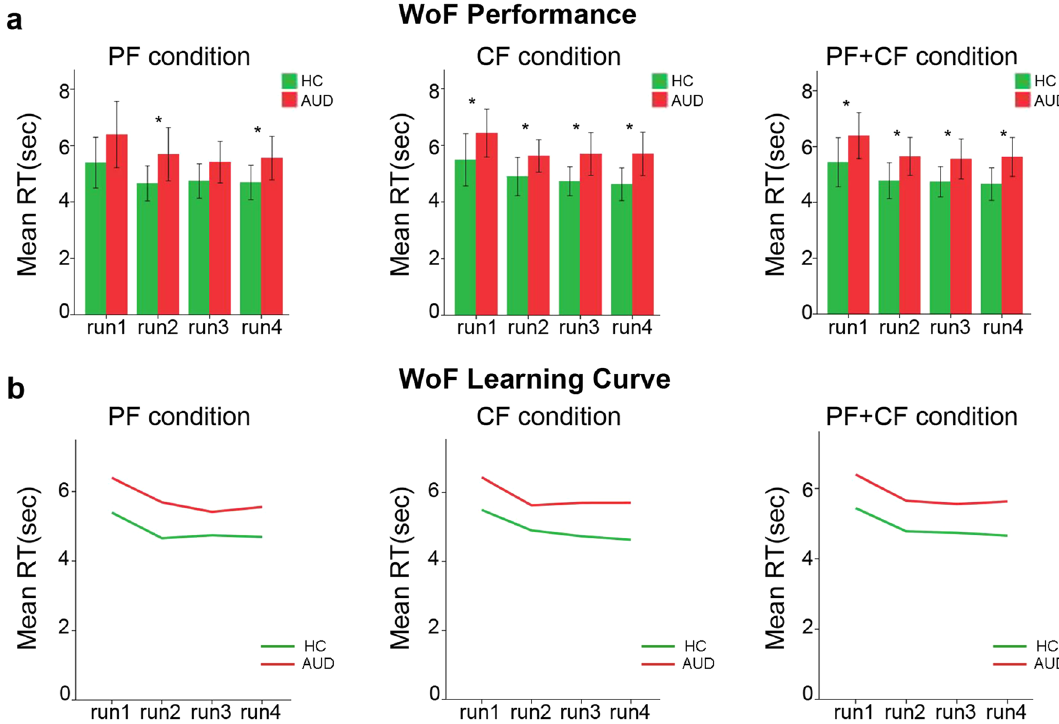
Figure 1. Task performance and learning curve. Panels ( a) and ( b) depict group differences in run-specific RTs and in learning curves, respectively, for partial- and complete-feedback conditions, or both.